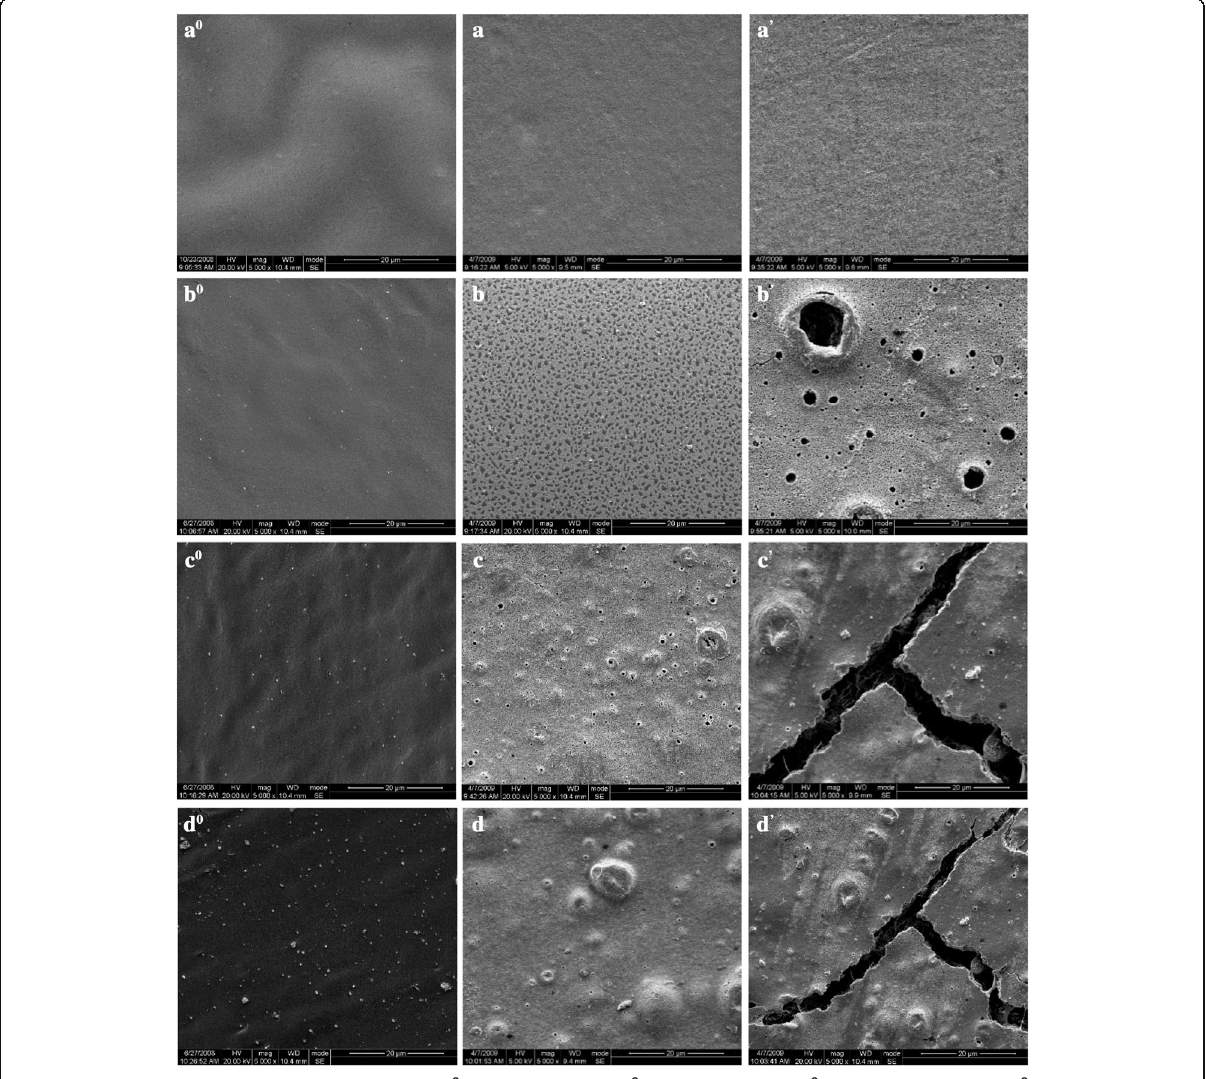
Fig. 1 SEM photography of the surface of pure PLA ( a 0 , a , a ’ ), PLA/TiO 2 – 2 ( b 0 , b , b ’ ), PLA/TiO 2 – 5 ( c 0 , c , c ’ ) and PLA/TiO 2 – 8 ( d 0 , d , d ’